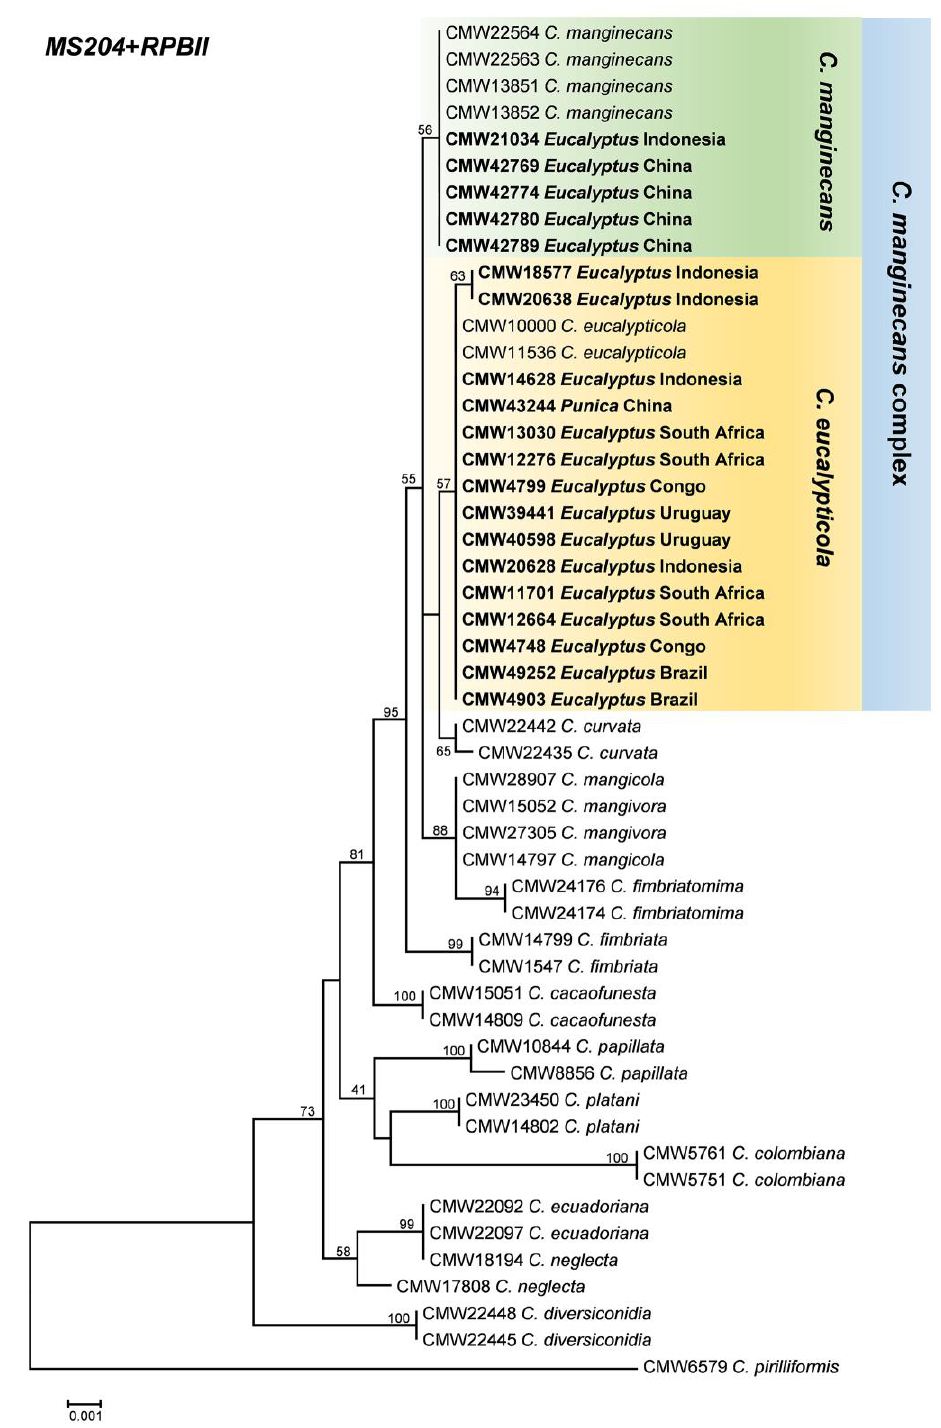
Figure 2. Phylogenetic tree based on maximum likelihood (ML) analysis of a combined dataset of MS204 and RPBII gene sequences for Ceratocystis isolates used in this study (only representative haplotypes per country and host were included in the analysis). Isolates in bold and highlighted in colored blocks are the isolates sequenced in this study and were either identified as C. manginecans or C. eucalypticola as part of the C. manginecans complex. Bootstrap values are presented above branches.